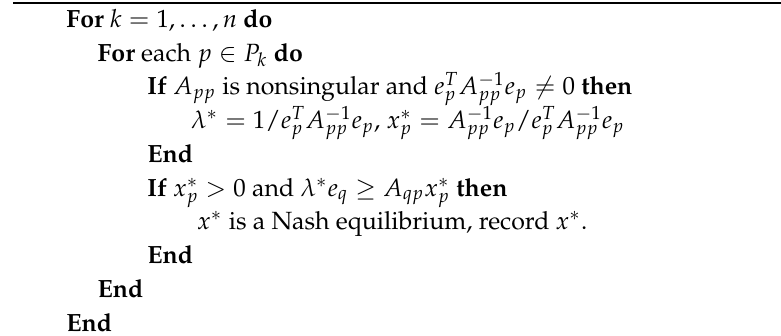
Algorithm 1: A Complete Shapley-Snow Algorithm For k = 1, . . . , n do